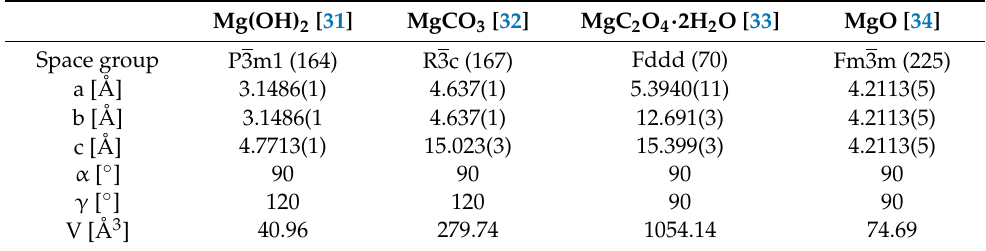
Table 1. Comparison of the crystallographic parameters of selected MgO precursors and